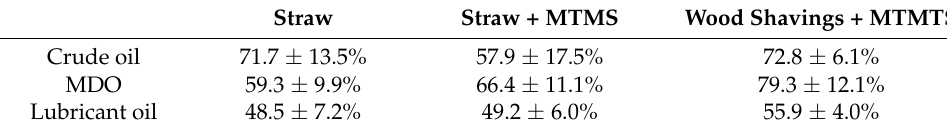
Table 2. Recovery of different kinds of oil concerning the different sorbents on day 1.